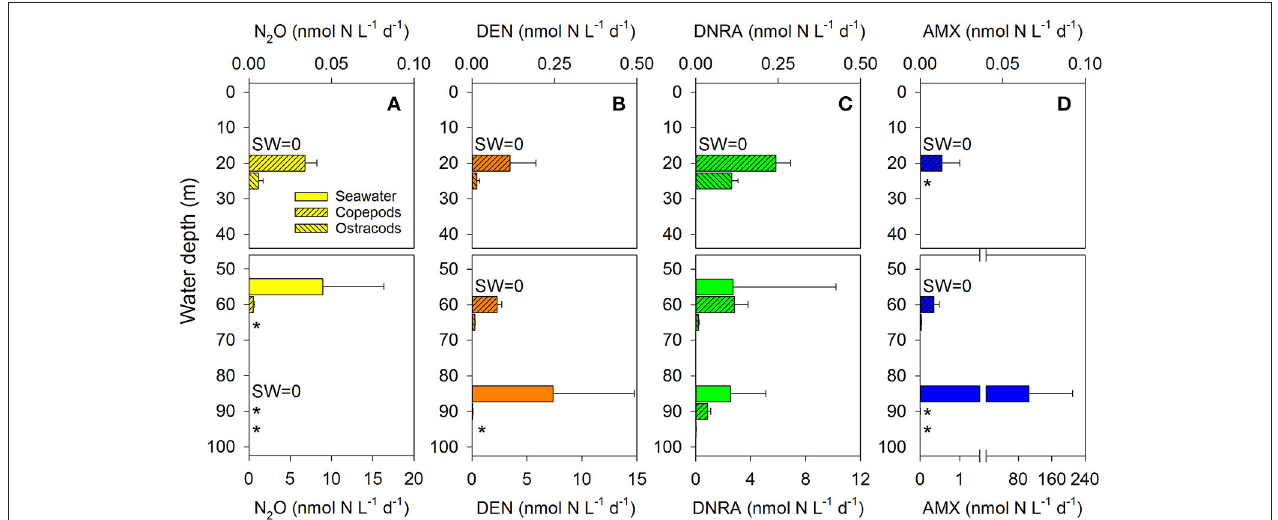
FIGURE 5 | Extrapolated N-cycling rates associated with zooplankton carcasses. Individual-specific rates of (A) N 2 O production, (B) denitrification (DEN), (C) DNRA, and (D) anammox (AMX) presented in Figure 3 were extrapolated to the in situ abundance of copepods and ostracods presented in Figure 2C and assuming a relative carcass abundance of 36% (Tang et al., 2014). N-cycling rates measured in seawater incubations are shown for comparison. Each panel is split into an upper and a lower part to account for the low rates measured in the oxic water layer. Means and standard error of 4–6 replicate measurements are shown. SW = 0 indicates rates in seawater incubations not significantly different from zero; * indicates rates in zooplankton incubations lower than 0.02 nmol N L − 1 d − 1 .